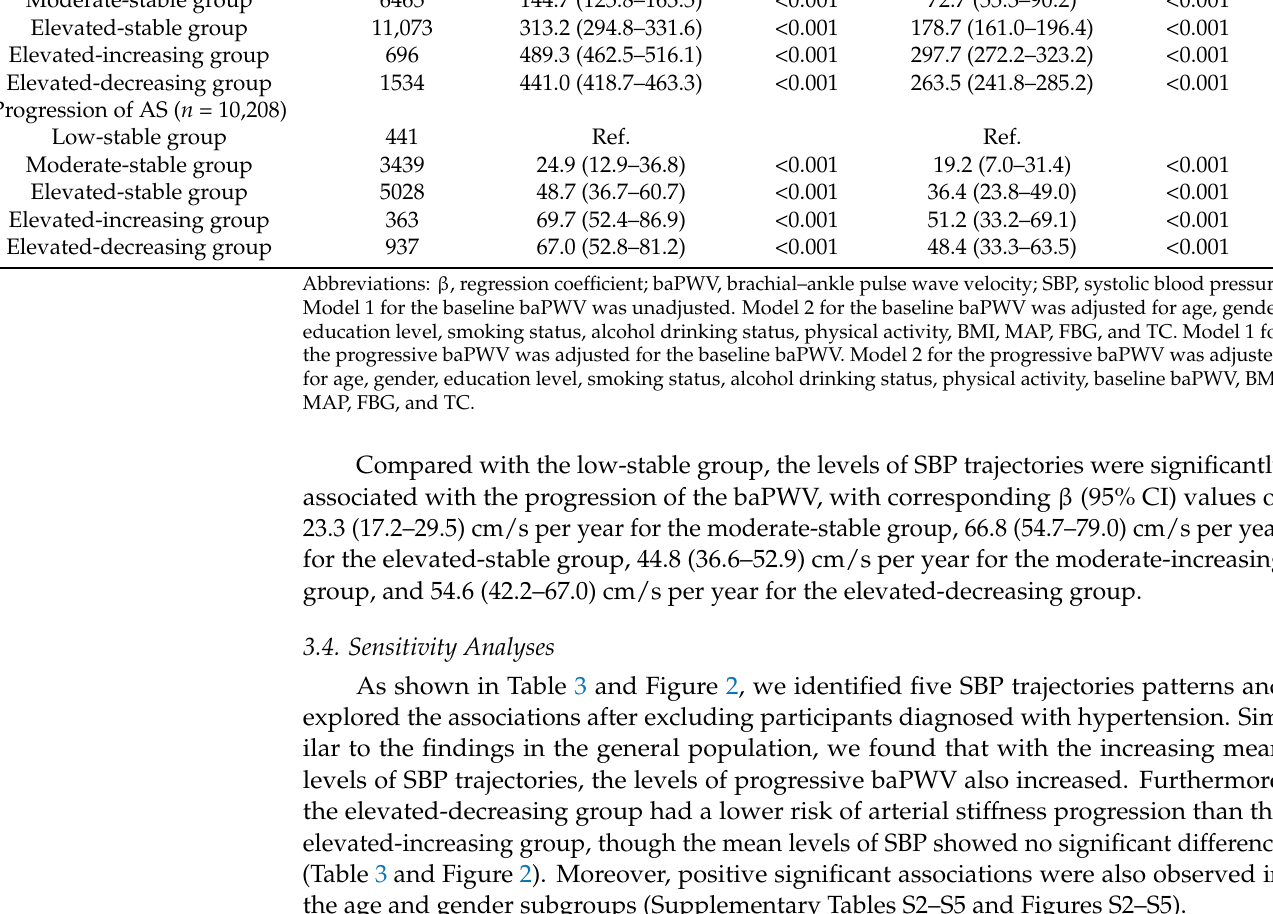
Table 3. Associations of the SBP trajectories with the baseline baPWV and progressive baPWV in non-hypertensive participants.